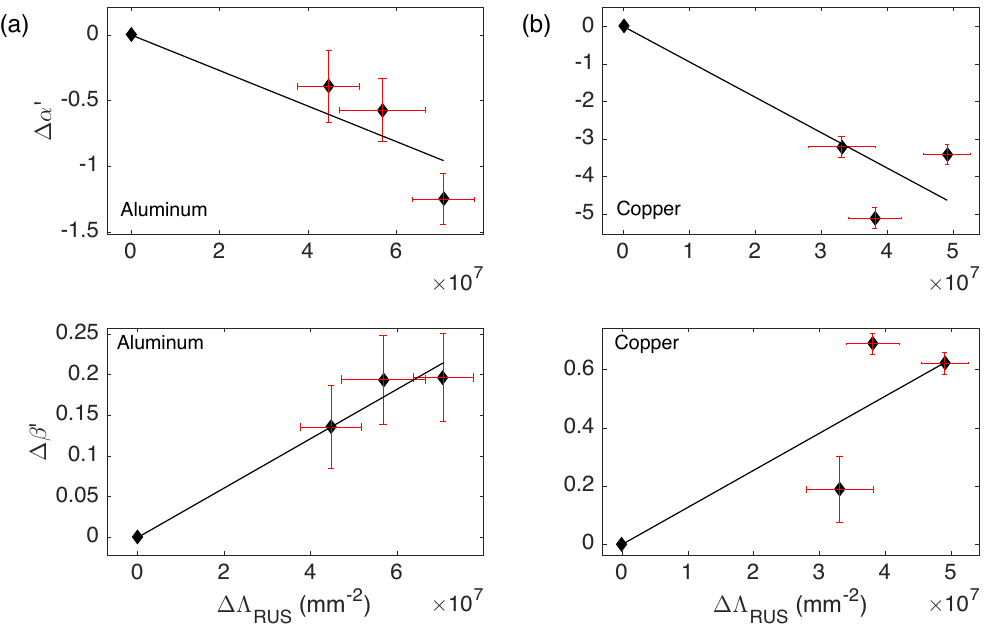
Figure 5. Normalized variations of nonlinear acoustic parameters α (cid:48) and β (cid:48) of each sample respect to the purely rolled one as functions of the variations of dislocation density, obtained with the linear measurements. For both groups Al and Cu, ∆Λ RUS are similar, which are obtained from changes in the transverse elastic wave speed v T , which are of the order of a few percent. ( a ) For the Al group, α (cid:48) shows changes of 39% to 125% and β (cid:48) of 14% to 20%; ( b ) For the Cu group, α (cid:48) shows changes of 320% to 510%, and β (cid:48) of 19% to